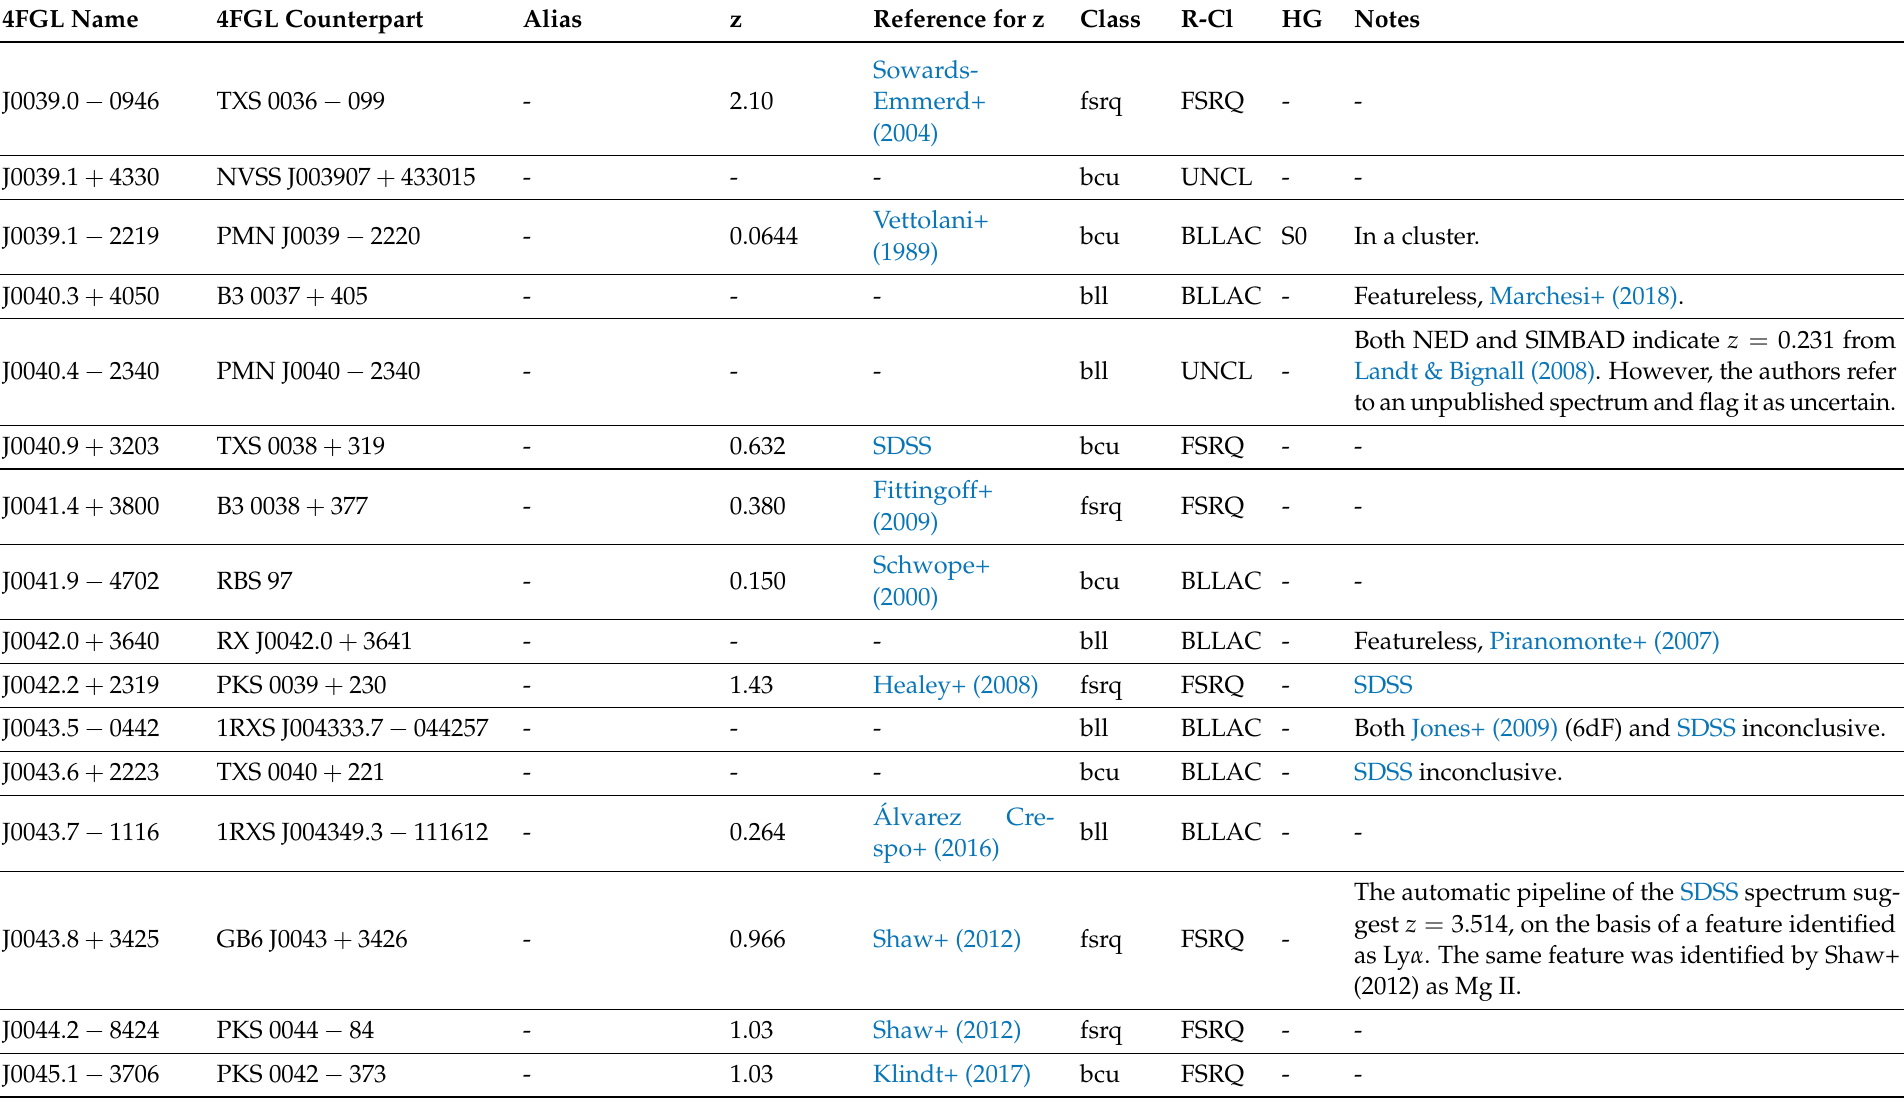
The automatic pipeline of the SDSS spectrum sug- gest z = 3.514, on the basis of a feature identified - as Ly α . The same feature was identified by Shaw+ (2012) as Mg